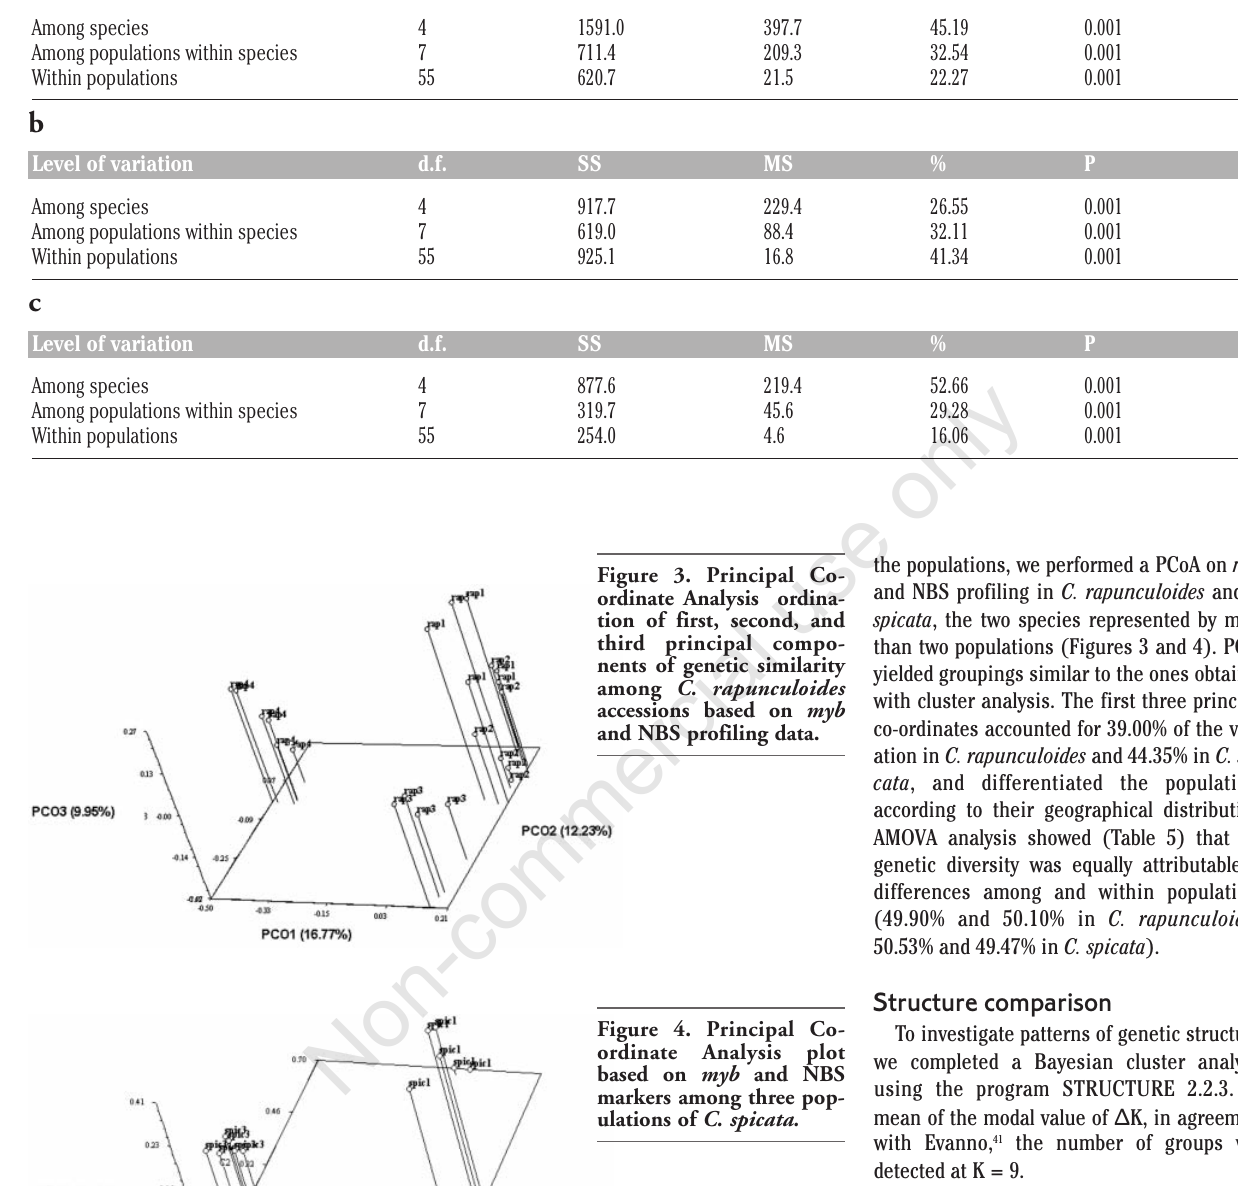
Figure 4. Principal Co- ordinate Analysis plot based on myb and NBS markers among three pop- ulations of C.